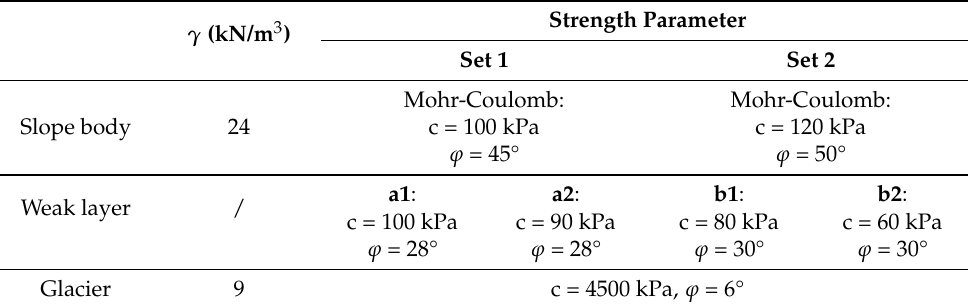
Table 8. The material properties assumed in the limit equilibrium method (LEM) analyses.